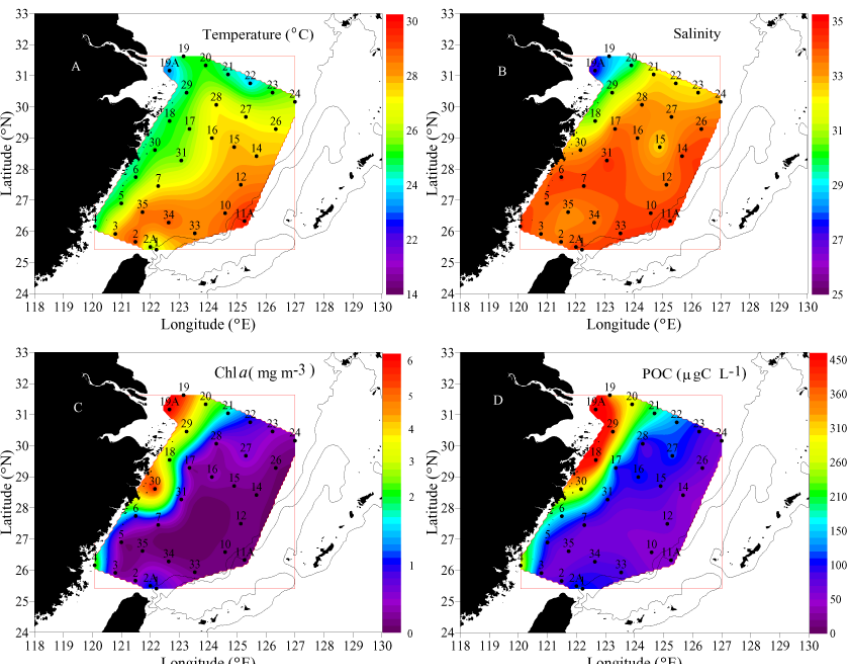
Fig. 2. Contours of surface temperature (A) , salinity (B) , chlorophyll (Chl a) concentration (C) and POC concentration (D) in the East China Sea in summer 2007,